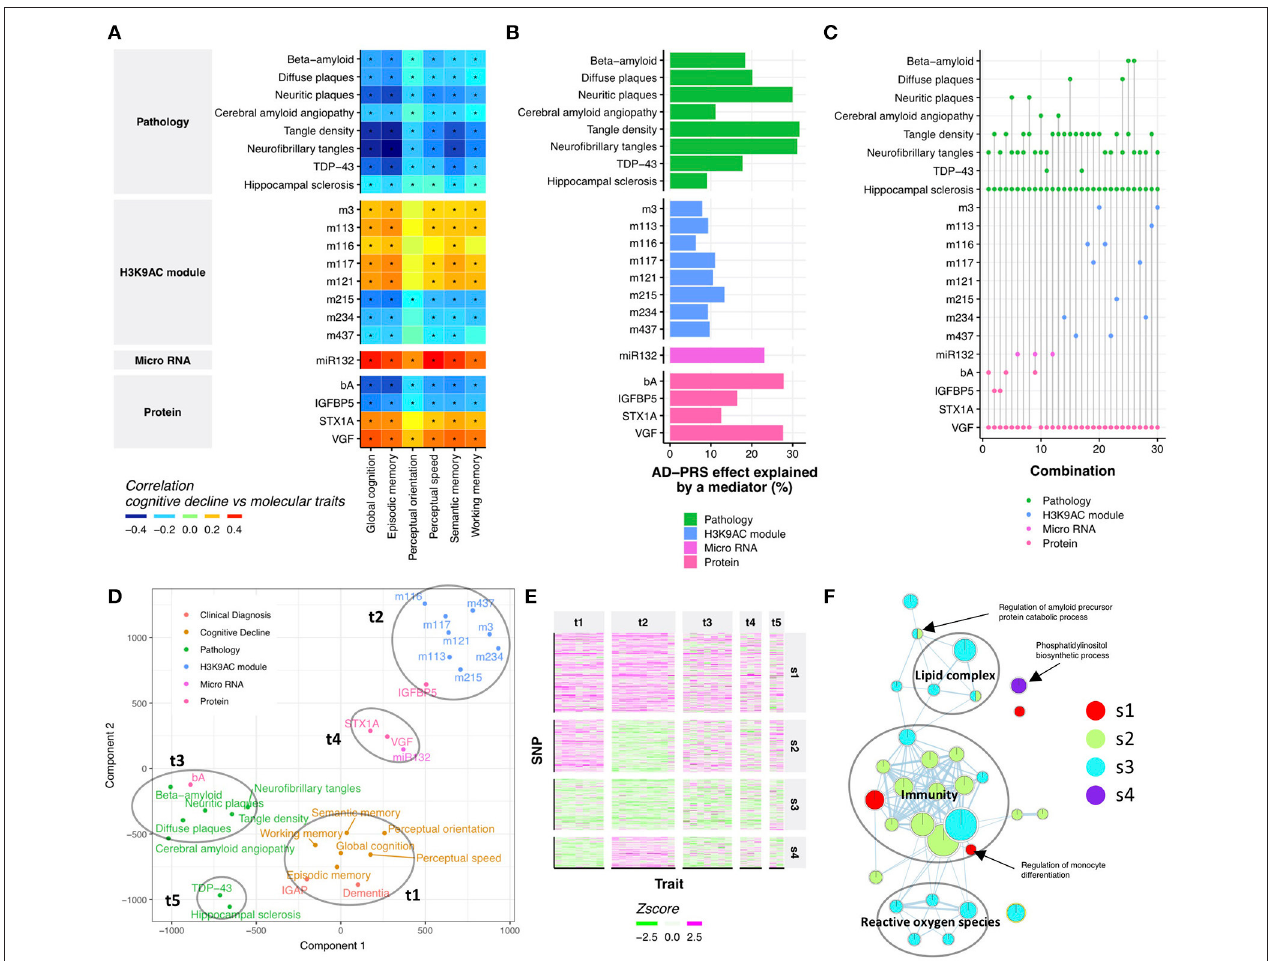
FIGURE 2 | Neuropathological and molecular traits mediating AD-PRS (A). Correlation between cognitive decline and AD-PRS-associated neuropathologies and molecular signatures. An asterisk indicates Bonferroni-corrected p < 0.05 (B) . The effect of AD-PRS on global cognitive decline explained by an endophenotype (C) . The sets of endophenotypes explain the effect of AD-PRS on global cognitive decline. The endophenotypes connected with a vertical line indicates the set of variables that made relationship between AD-PRS and global cognitive decline independent ( p > 0.05) (D) . Traits map based on genetic associations. The trait map is generated by calculating the distance between traits in terms of genetic associations. The distance between traits was calculated using the Jaccard index and projected on to two-dimensional by t-SNE (E) . Heatmap of trait-SNP associations. The SNPs in the AD-PRS were clustered using the SpeakEasy consensus clustering method (F) . GO enrichment map for SNP clusters. GO enrichment for SNP clusters were conducted using the GREAT algorithm and the significant associations (FDR < 0.05) were visualized by EnrichmentMap.